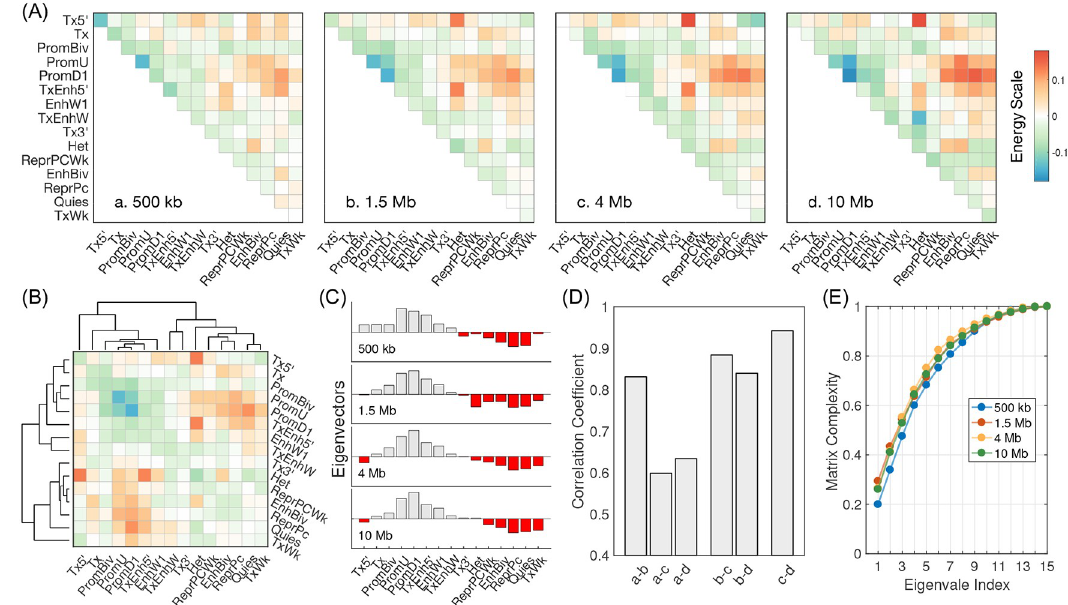
Fig 7. Dependence of chromatin state interaction energies on genomic separation. (A) Heat maps for the interaction matrices at various genomic separations, with blue and red corresponding to attractive and repulsive interactions respectively. We subtracted out the mean of the interaction energies in order to shift different plots to the same scale. (B) Dendrogram calculated using the interaction energy matrix at 1.5 Mb to highlight the hierarchical clustering of chromatin states. The coloring scheme is the same as in part (A). (C) The eigenvectors corresponding to the largest eigenvalues of the four interaction matrices, with grey and red indicating positive and negative values respectively. (D) Pearson correlation coefficients between interaction matrices at different scales. (E) The complexity measure for different interaction matrices as a function of the index for top eigenvalues. See text for the definition of the complexity measure.